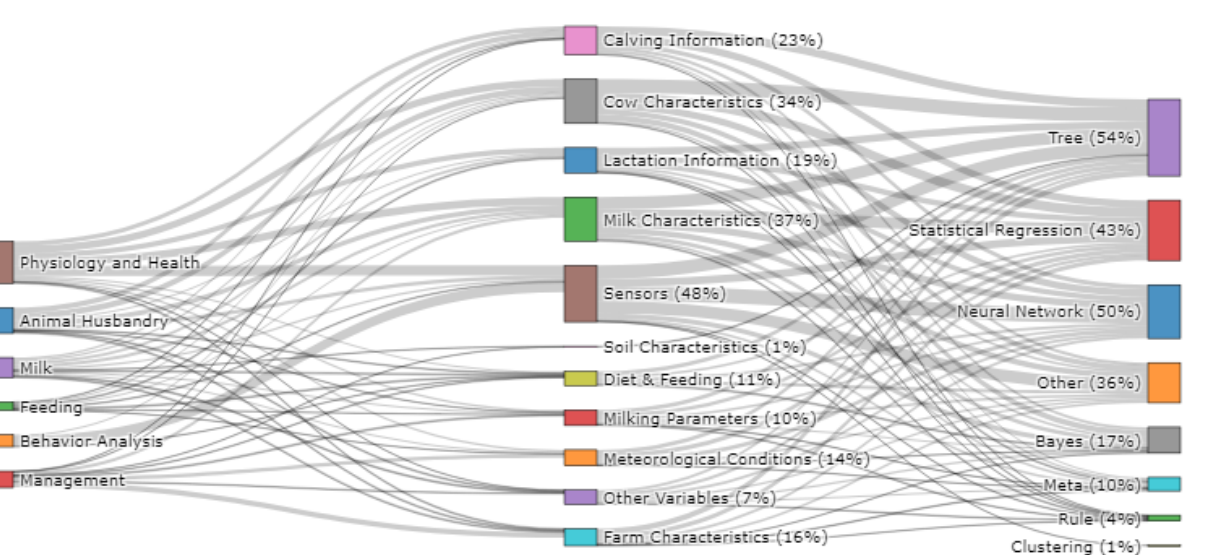
Figure 6. Flow of studies from research area to features categories to algorithm categories (n = 134).